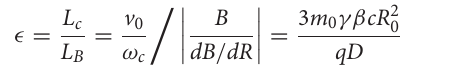
10 R E ˆ X along a −